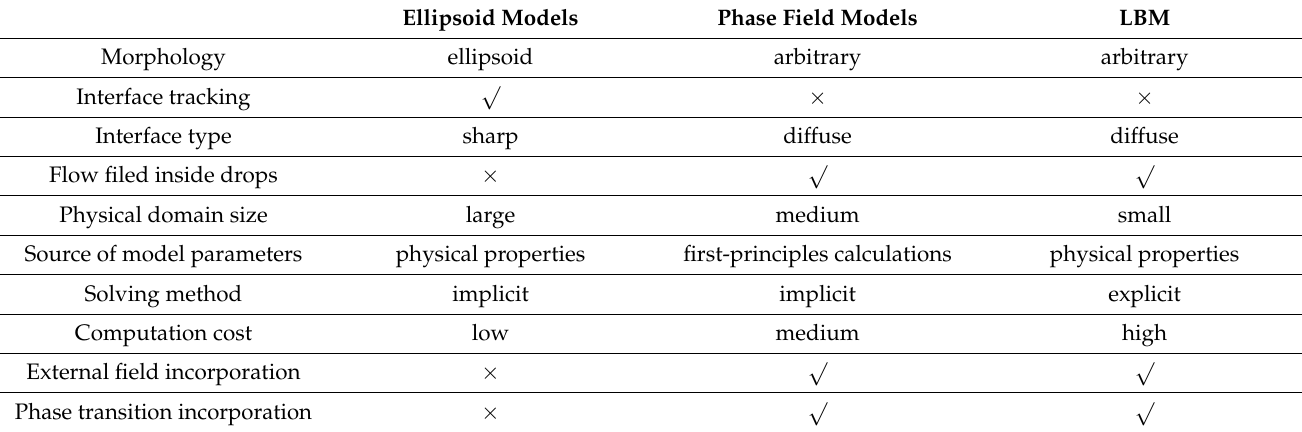
Table 1. Comparison of three droplet morphology evolution